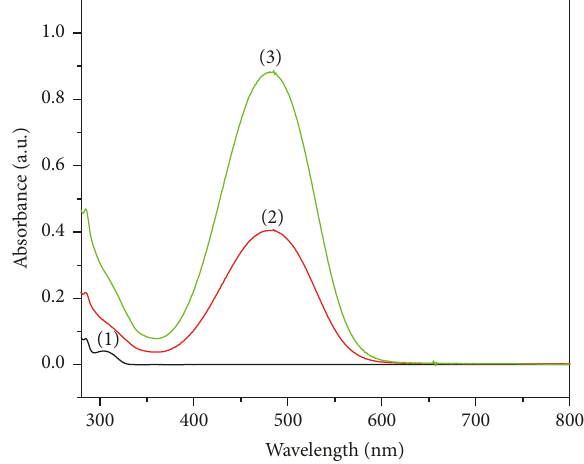
Figure 7: UV-vis spectra of the THF solution (0.02mg/mL) of the polymers. Curve (1): PAZ, curve (2): PAZ-NT-PAZ, and curve (3):